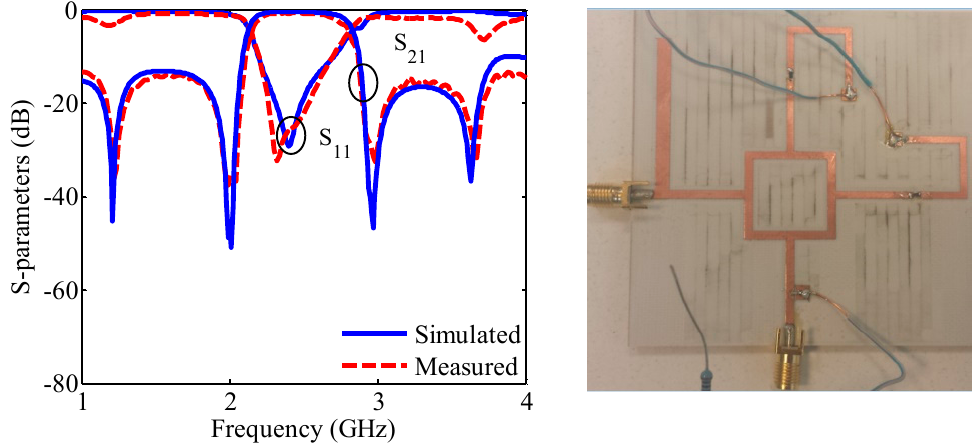
Figure 11. Simulated and measured S -parameter results of reconfigurable bandwidth BPF with 3 λ g /4 open-ended stubs for the narrowband state along with fabricated prototype.